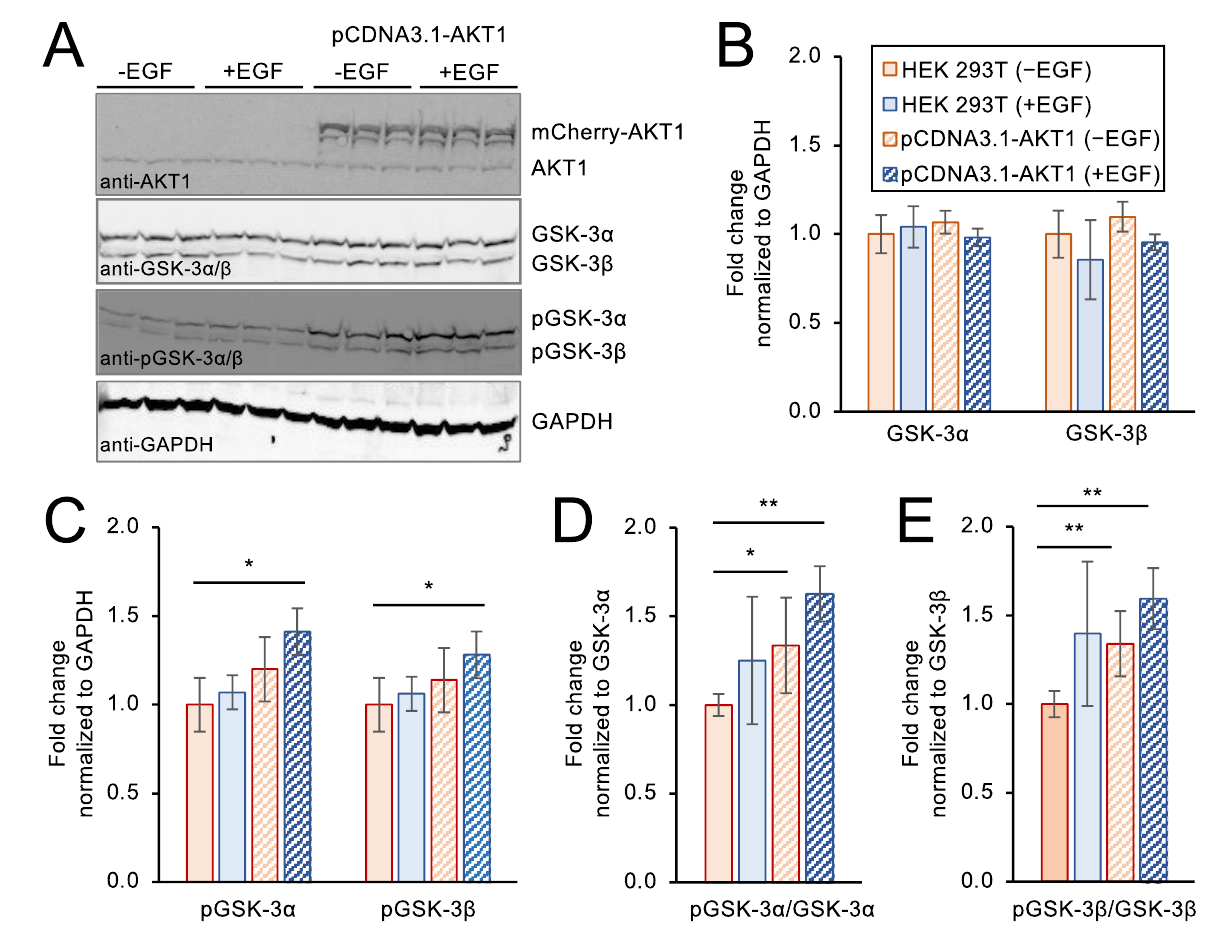
Figure 6. AKT1 over-expression and growth factor stimulation activates AKT1 signaling in HEK 293T cells. HEK 293T cells were transfected with an mCherry-AKT1 over-expression plasmid. At 24 hours after transfection, cells were stimulated with EGF for 10 min. ( A ) Cell extracts were separated by SDS-PAGE and immunoblotted with AKT1, GSK-3, pGSK-3, and GAPDH specific antibodies in three biological replicates. ( B ) Quantification of western blots showed no change in GSK- 3α or GSK - 3β protein abundance. ( C ) GSK- 3α and GSK - 3β phosphorylation normalized to GAPDH was significantly increased in cells over-expressing AKT1 after EGF stimulation, but not significantly changed in EGF stimulated cells alone or unstimulated cells over-expressing AKT1. ( D ) GSK- 3α and ( E ) GSK- 3β phosphorylation was also normalized to GSK - 3α and GSK- 3β levels, showing increased phosphorylation of both GSK-3 isoforms in response to AKT1 over-expression, which was further increased upon EGF stimulation. Error bars represent the standard deviation of the mean. p -values were calculated by two-tailed t-test and are indicated by asterisks (* p < 0.05, ** p < 0.01).